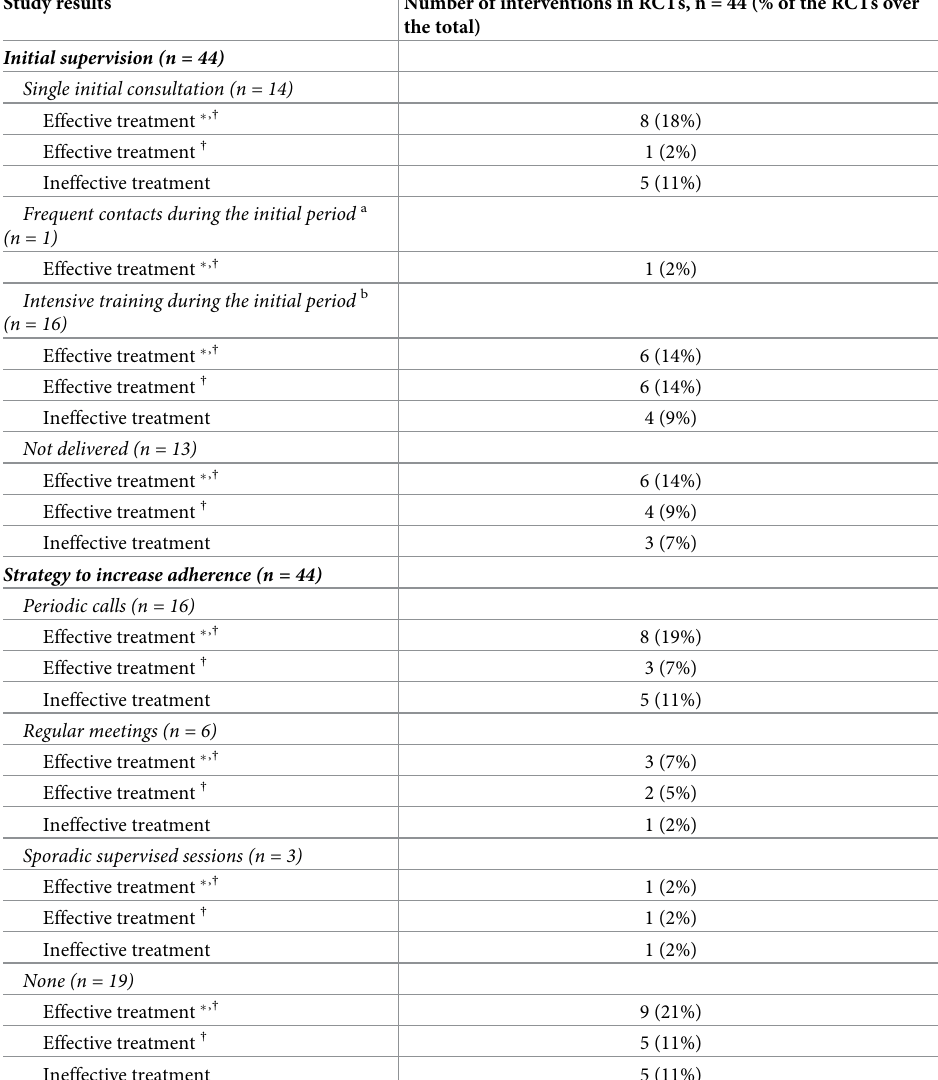
Table 7. RCT results based on the initial supervision provided before self-care and on strategies employed to pro- mote adherence during self-managed activities. Counts are presented both as raw data and percentages computed over the total (n =